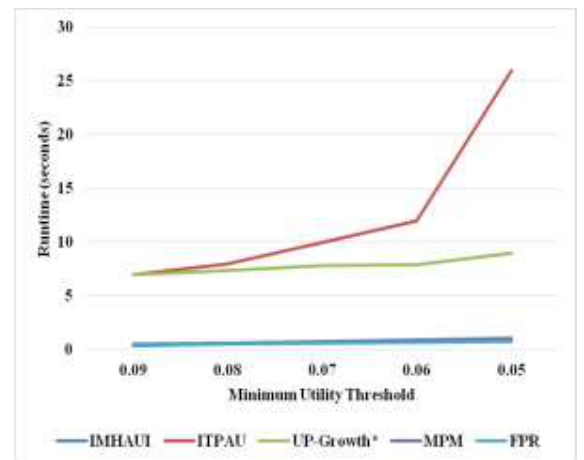
Figure 2. Breast_Cancer_Wisconsin